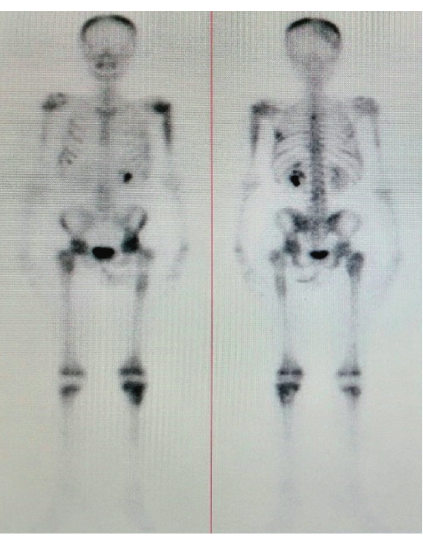
Figure 5: Skeletal scintigraphy showing multiple bone